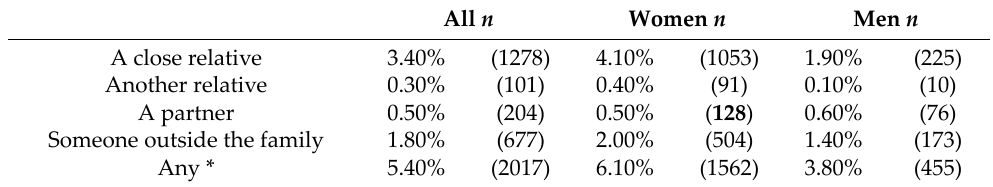
Table 3. Prevalence of type of care relationship in male and female college and university